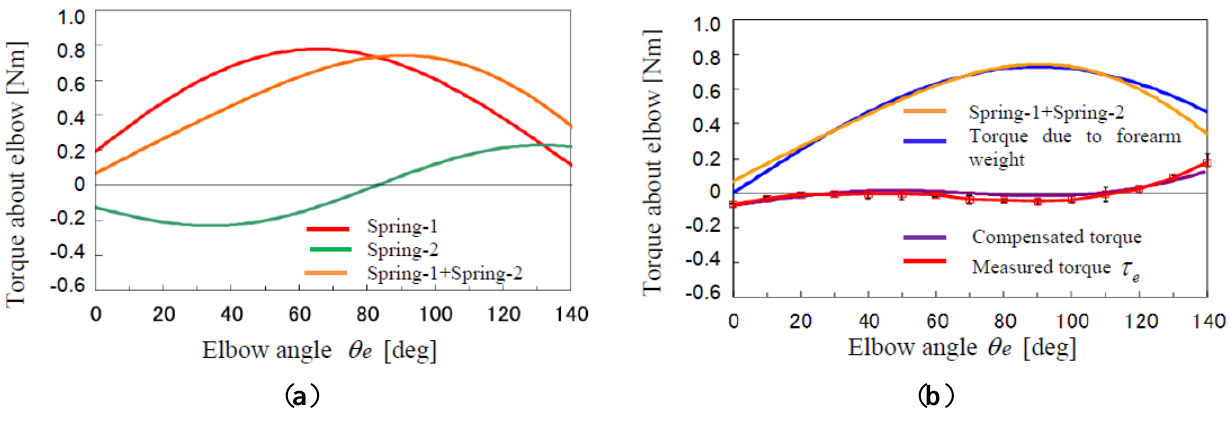
Figure 10. Theoretical and Experimental result of weight compensation of the forearm. ( a ) Torques at the elbow joint due to springs; ( b ) Torques at the elbow joint due to springs, forearm weight and their compensating